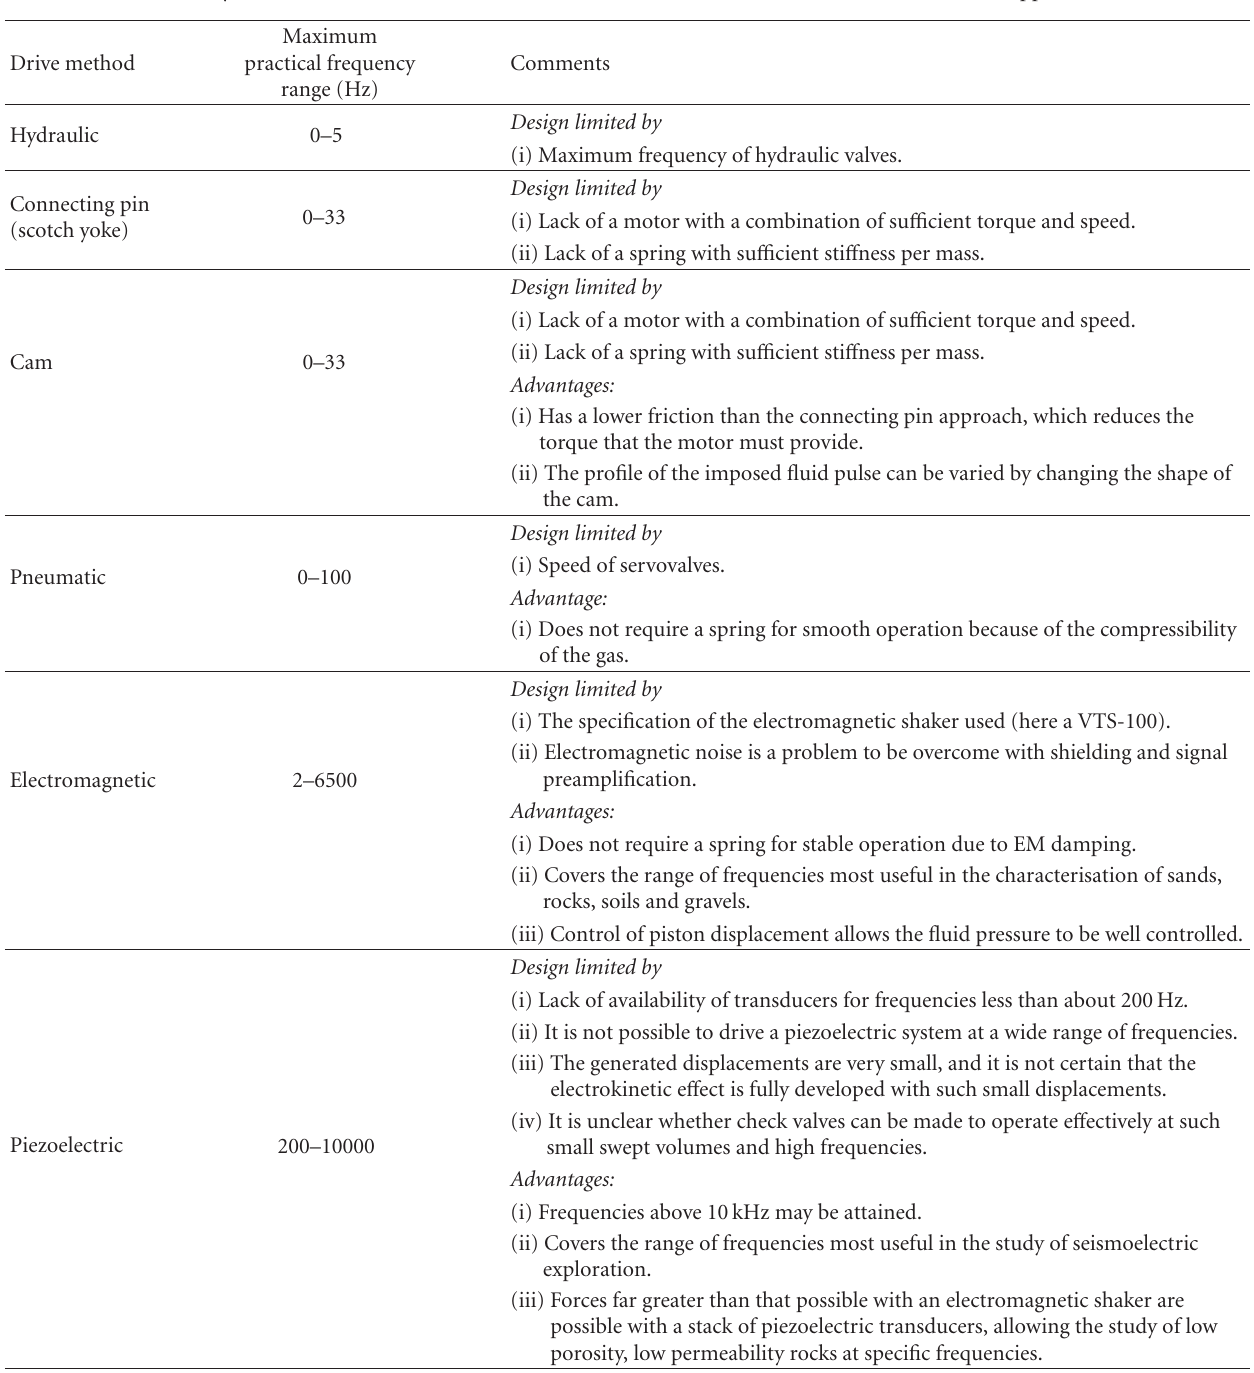
Table 2: Summary of the main characteristics and limitations of each of the drive methods. Please see the appendix for